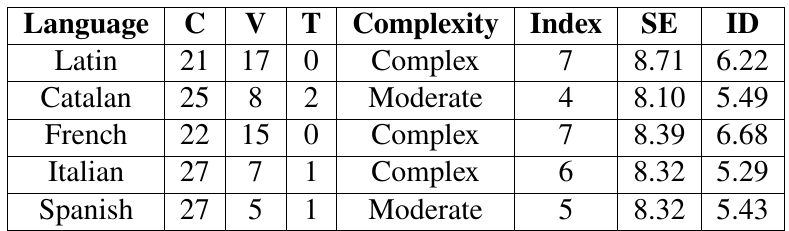
Table 2. Phonological statistics for Classical Latin compared to modern Romance languages: number of consonants, vowels, and tone/stress features; complexity and complexity index; Shan- non entropy and information